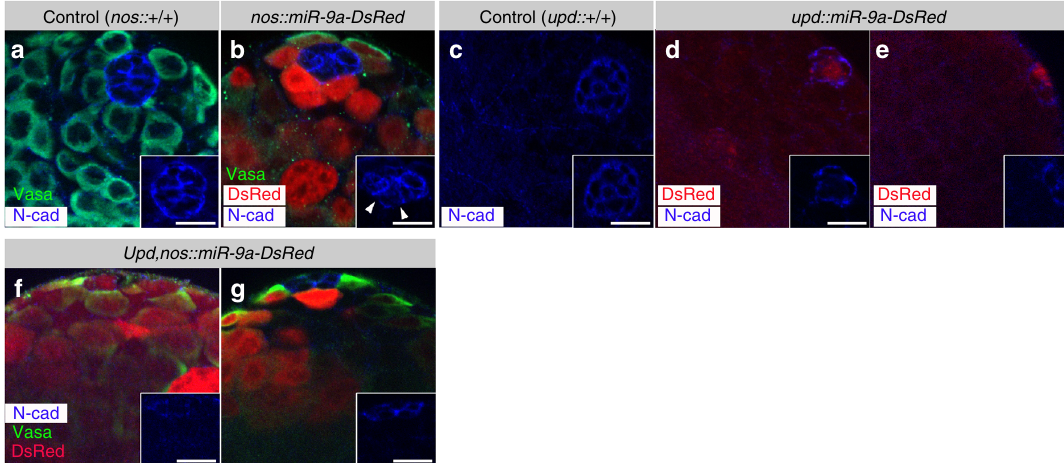
Fig. 4 miR-9a overexpression reduces N-cad. Ectopic expression of DsRed-miR-9a in GSCs and progenitor germ cells ( a , b ) or the hub ( c – e ) or in both the hub and GSCs ( f , g ) reduces N-cad expression. Testes detected for DsRed ( red ) and were stained with N-cad ( blue ) and Vasa ( green ). a , b Control ( nos- GAL4 outcrossed to w 1118 ) and miR-9a overexpression in the GSCs and progenitor germ cells ( nos-GAL4,UAS-DsRed-miR-9a ). Note N-cad reduction between GSCs and hub cells ( b and inset ). c – e Control ( upd-GAL4 outcrossed to w 1118 ) and miR-9a overexpression in the hub ( upd-GAL4;UAS-DsRed-miR- 9a ). Note N-cad reduction between hub cells ( d , e , and insets ). f , g Simultaneous expression of miR-9a in both the hub and GSCs ( upd-GAL4;nos-GAL4,UAS- DsRed-miR-9a ). 36% of the testes showed DsRed-miR-9a both in the hub and germline ( f , n = 39) and 64% showed DsRed-miR-9a only in the germline ( g ). Note a dramatic reduction of N-cad among hub cells and between hub and GSCs ( f and inset ). Scale bars 10 µ